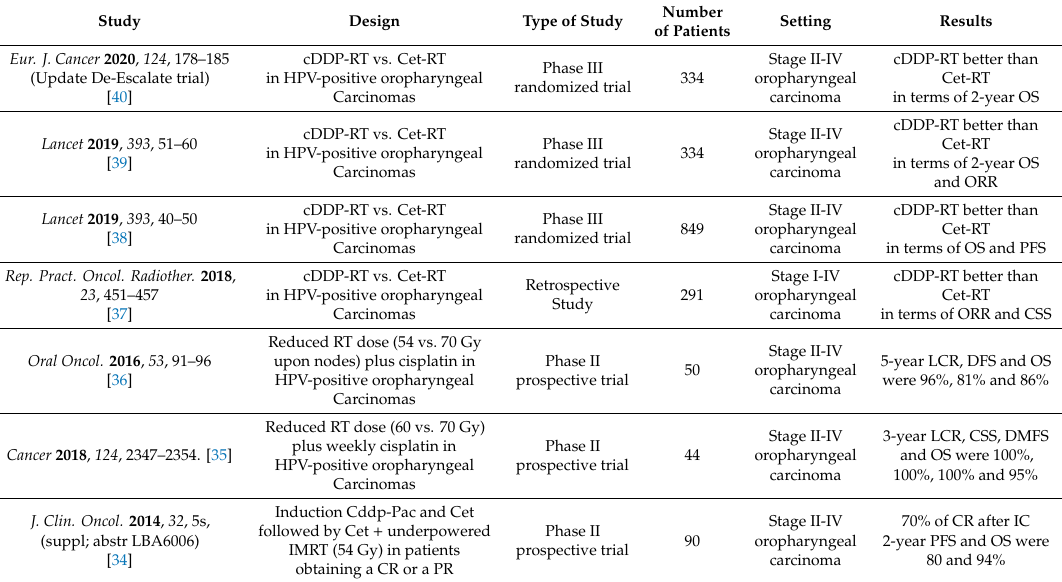
Table 2. Trials exploring the concept of de-intensification of the standard chemoradiotherapy regimen in patients with HPV-positive